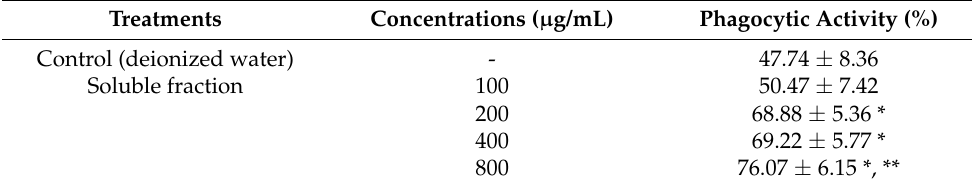
Figure 1. Representative images of phagocytosis of C. albicans by human neutrophils. Cells from control—( A ); deionized water) and HCFP—( B ); 800 µ g/mL) treatments were stained by Giemsa staining and examined under a light microscope. The neutrophils (n) were incubated with C. albicans (c) and soluble fraction of HCFP at 37 ◦ C for 30 min. The Candida-engulfed neutrophils (nc) were counted as positive cells. Scale bar = 20 µ m. Table 1. Effect of soluble fraction (lyophilized powder) of HCFP on phagocytic activity of human